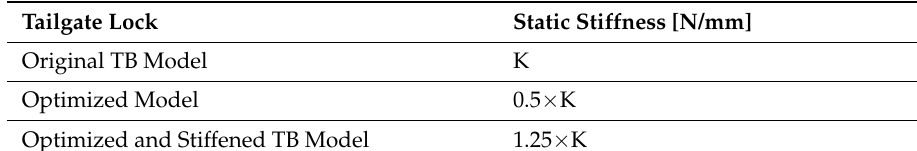
Table 3. Static stiffness of the tailgate lock.